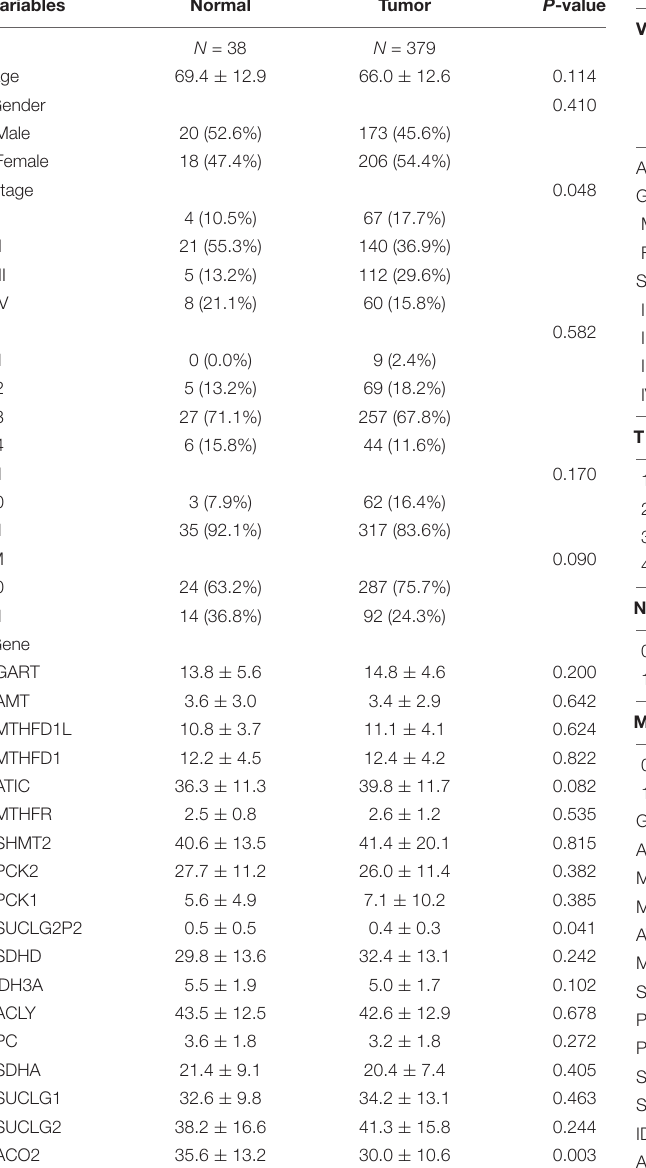
TABLE 2 | The characteristics of patients in the TCGA-COAD cohort. TABLE 3 | Univariate and Multivariable Cox hazard regression analysis for prognostic